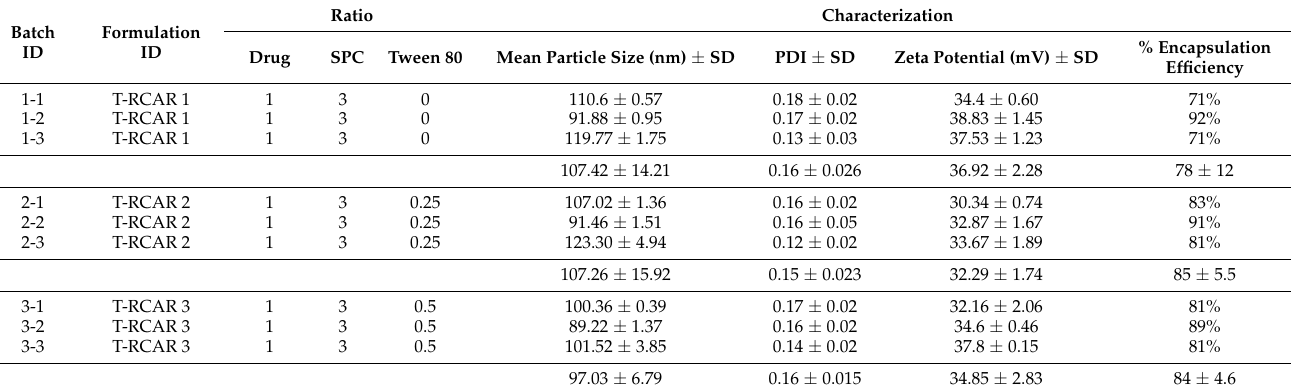
Table 2. Physical characteristics of R-carvedilol-loaded